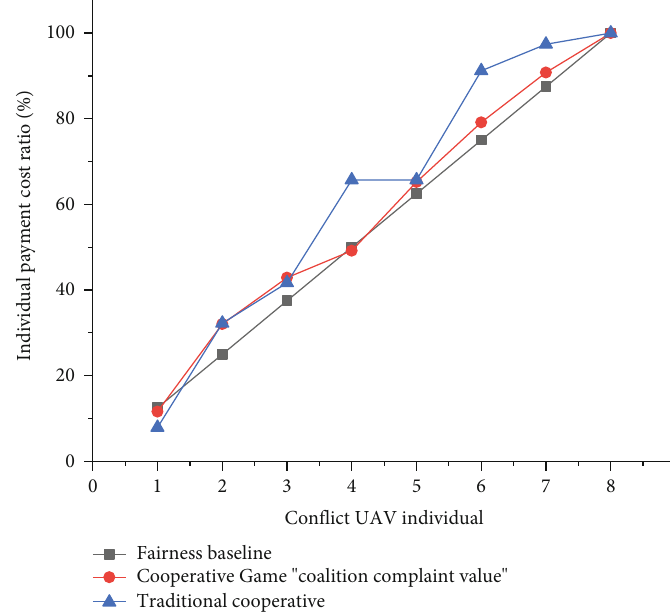
Figure 15: Comparison of individual fairness between the two solutions under scenario